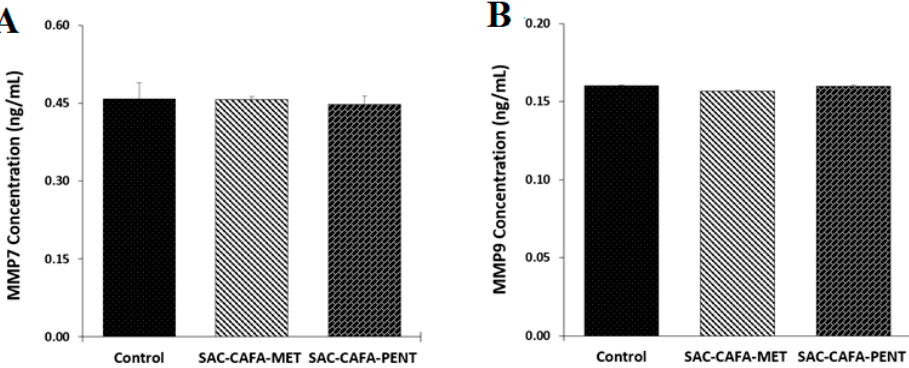
Figure 4. Concentrations of matrix metalloproteinase 7 (MMP7) ( A ) and MMP9 ( B ). Data are presented as the mean ± SE of three independent experiments.